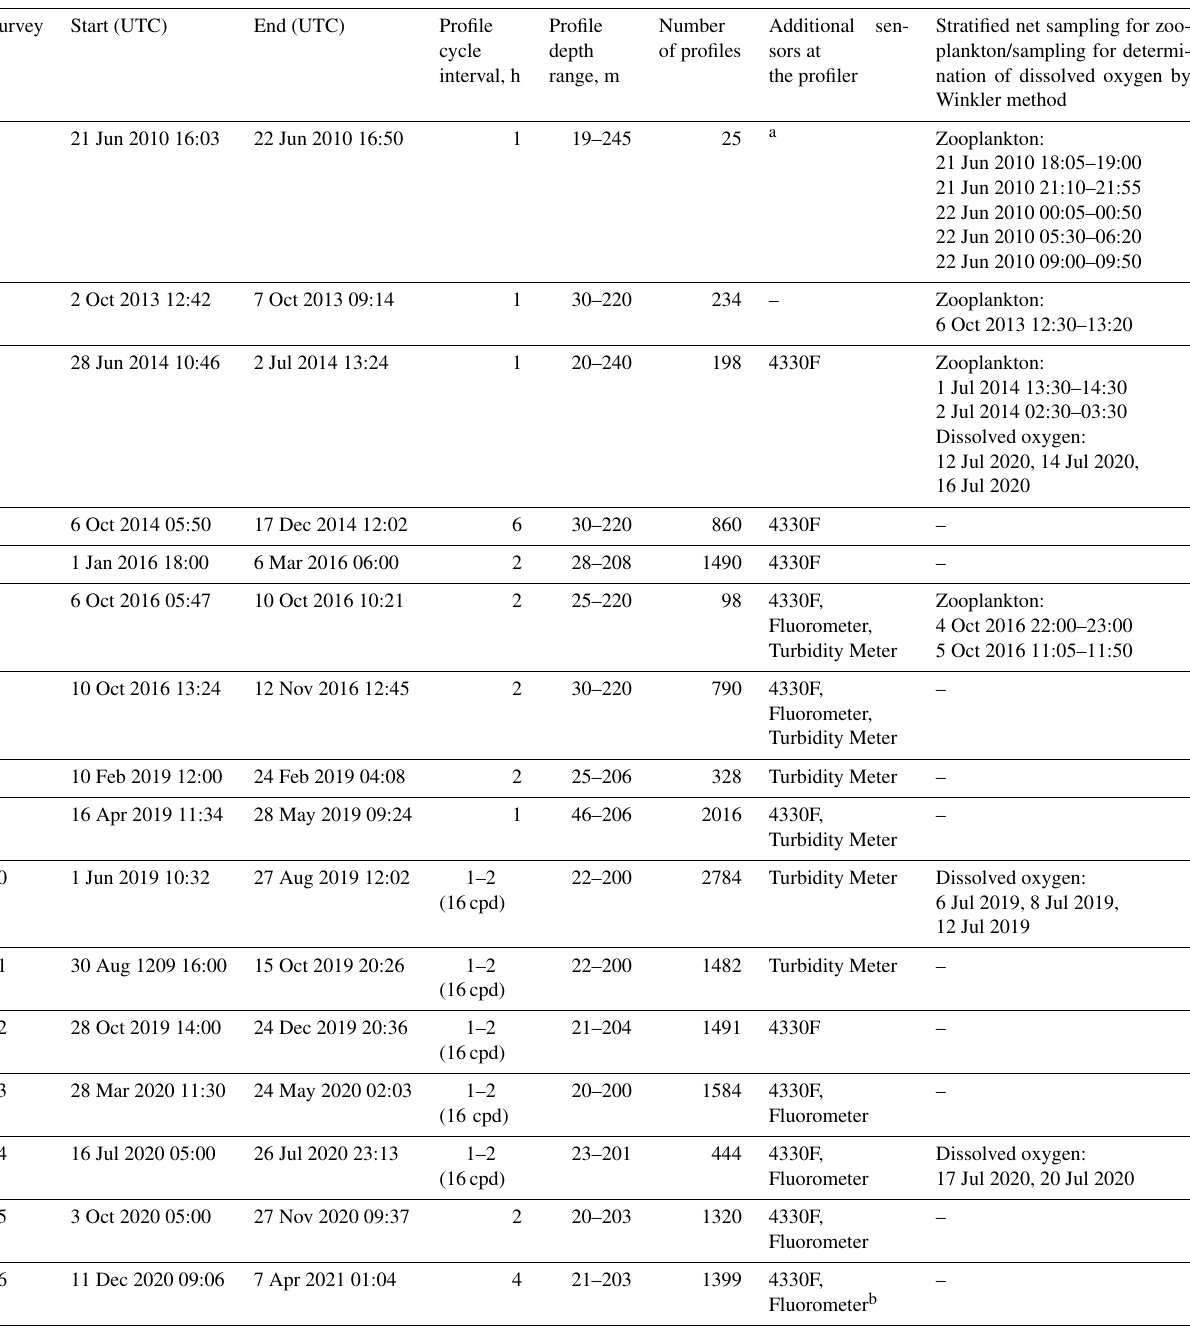
Table 1. Deployments of the profiler Aqualog-6 with a Nortek Aquadopp current meter in the NE Black Sea and the dates of the zooplankton sampling near the profiler mooring site in 2010–2021. Since 2013, the profiler Aqualog has been equipped with a SBE 52MP CTD probe with a SBE 43F DO sensor. Additional sensors used on the profiler were as follows: Oxygen Aanderaa 4330F, Seapoint Turbidity Meter, and Seapoint Fluorometer. The unit “cpd” denotes the profiling cycles per day. Survey